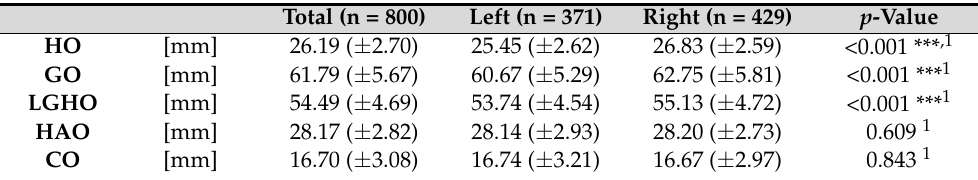
Table 1. Analysis of side-specific differences between offset parameters.